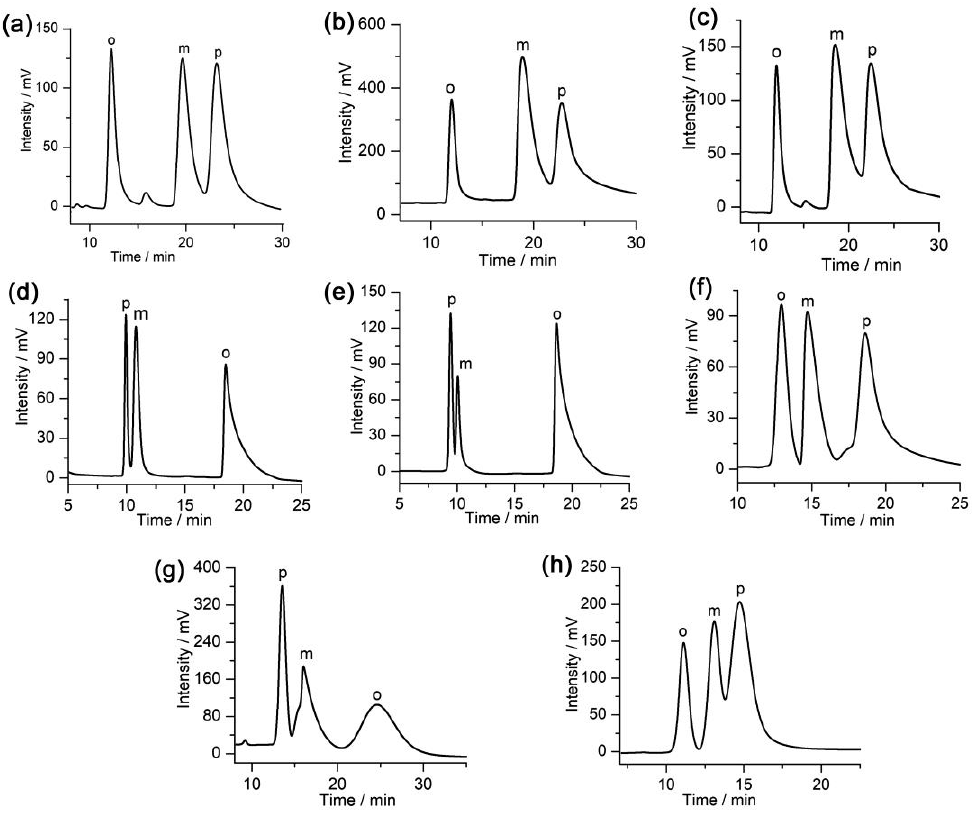
Figure 4. Chromatograms obtained for the separation of positional isomers on the chiral POC-based CSP packed column: ( a ) iodoaniline, ( b ) bromoaniline, ( c ) chloroaniline, ( d ) dibromobenzene, ( e ) dichlorobenzene, ( f ) toluidine, ( g ) nitrobromobenzene, and ( h ) nitroaniline.